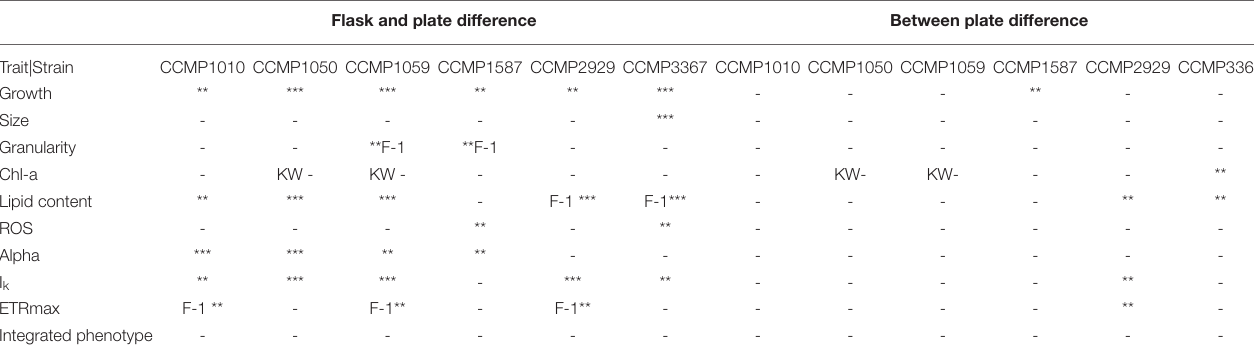
TABLE 2 | Summary of comparisons of individual trait values and integrated phenotypes between flask and plate-grown cultures for six Thalassiosira strains. Flask and plate difference Between plate difference